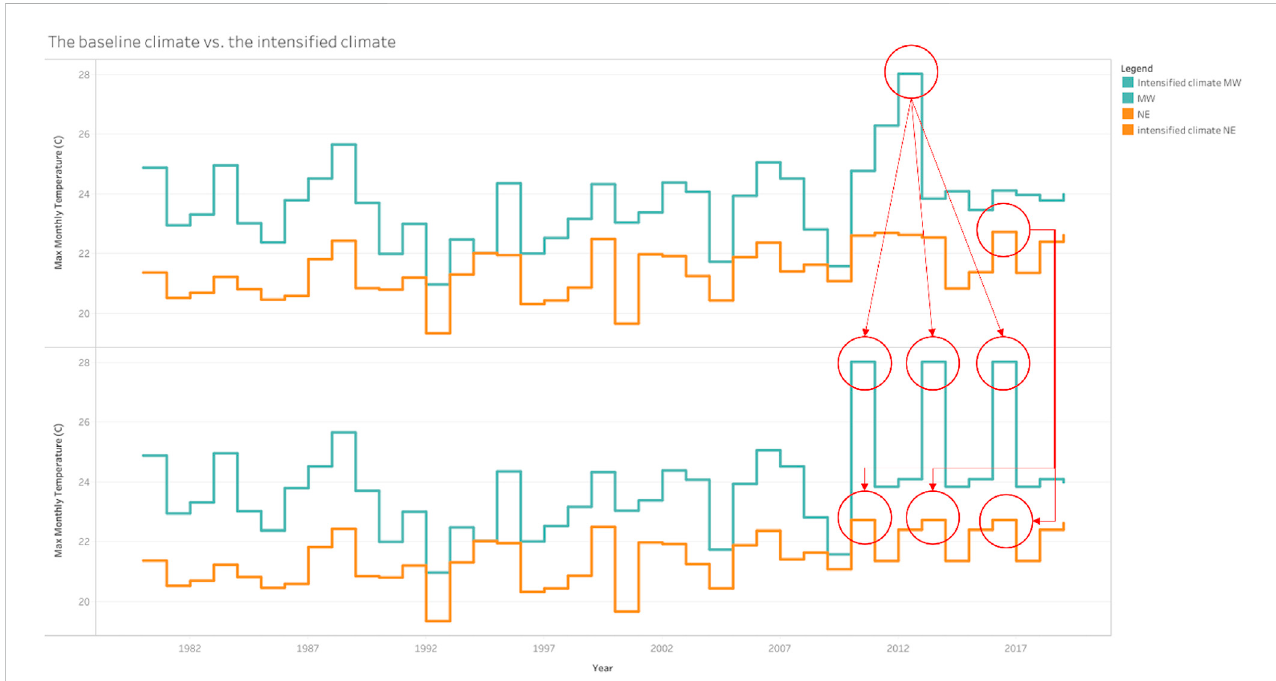
FIGURE 4 Demonstration of creation ofextreme climatescenarios. Note: The extreme heat wave event from 2010 – 2019 was identi fi edand replicated three times across the last decade of C-FEWS framework of